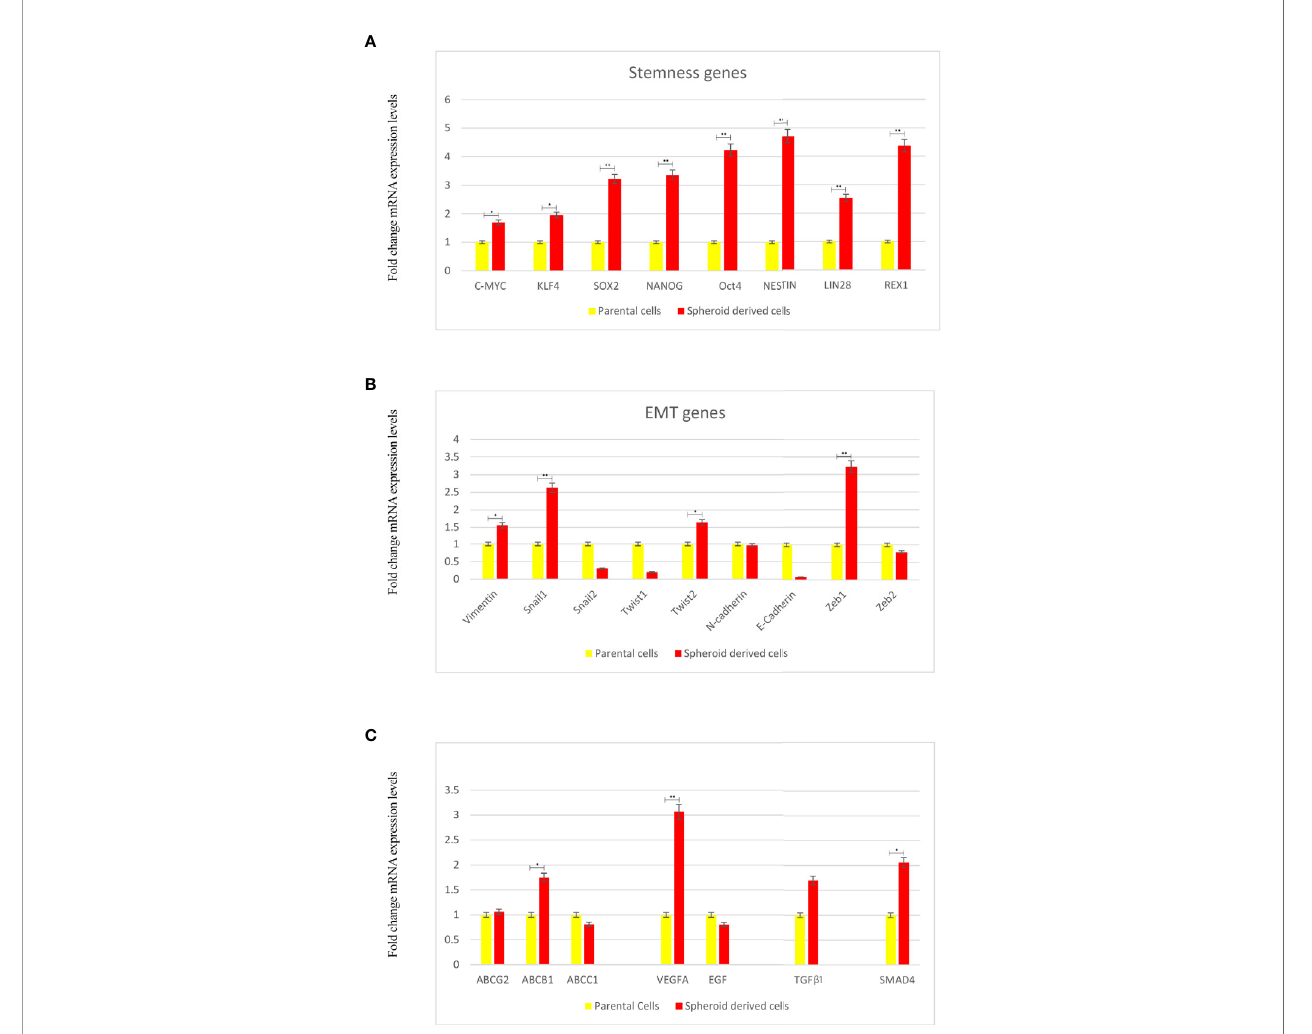
FIGURE 5 | Expression Levels of Stemness, EMT, and Angiogenesis-Related Genes and TGF- b 1 using qRT-PCR in Parental Cells (PCs) and Spheroid-Derived Cells (SDCs) From Before and After Transfection of PCs with SiSMAD4. (A) Stem cell marker, (B) Mesenchymal marker, (C) ABC transporters, Angiogenesis-related and TGF- b 1 genes expression of PCs and SDCs in SFDM and SDCs established by SMAD4 inhibition were quanti fi ed by qRT-PCR. Data are represented as mean ± SD (n = 3 each). * P < 0.05, and ** P <